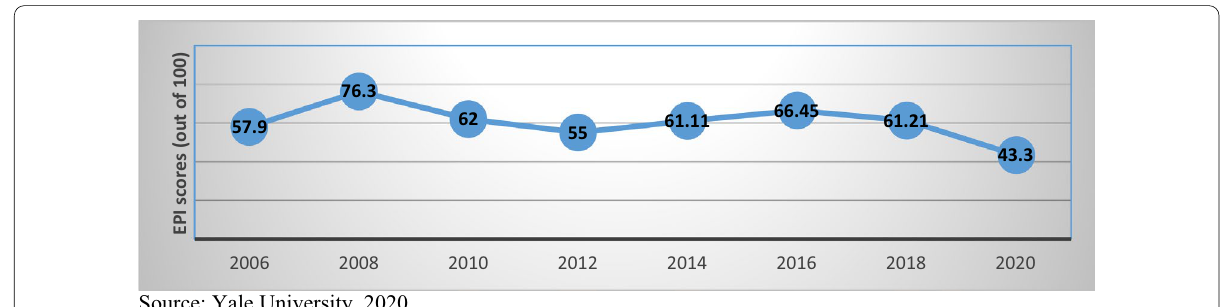
Fig. 4 Environmental performance index (EPI) in Egypt (out of 100). Source: [24]